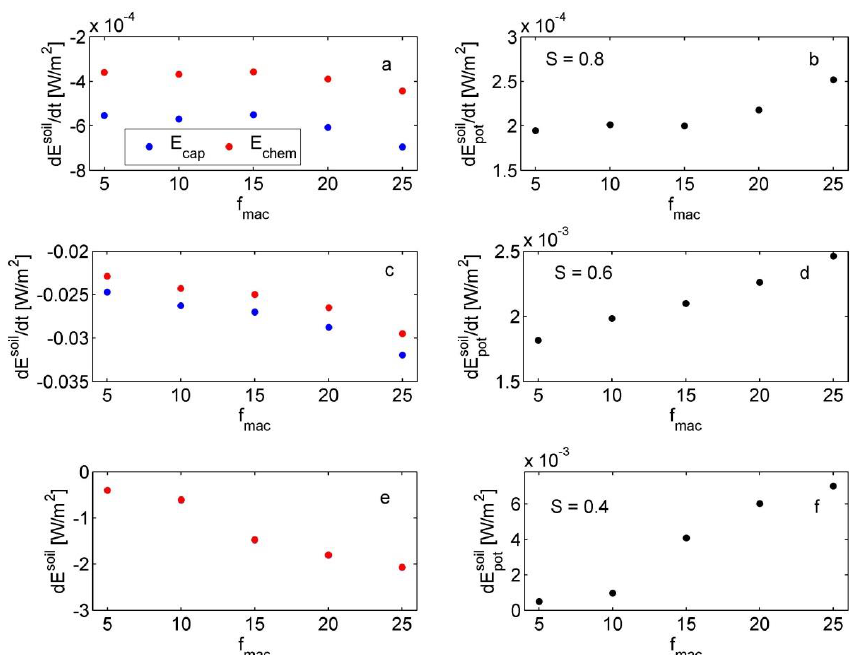
Fig. 6. Averaged reduction in absolute values of capillary binding energy (blue dots, a , c , e ), enlargement of potential energy (black dots, b , Figure 6: Averaged reduction in absolute values of capillary binding energy (blue dots, panels d , f ) and reduction of free energy of soil water (red dots, a , c , e , Eq. 8) for numerical experiment 1. Average initial saturation decreases from a, c, e), enlargement of potential energy (black dots, panels b, d, f) and reduction of free top to the bottom panels as indicated in panels from 0.8 over 0.6 to energy of soil water (red dots, panels a, c, e Eq. 8) for numerical experiment 1. Average initial saturation decreases from top to the bottom panels as indicated in panels b, d, and f.